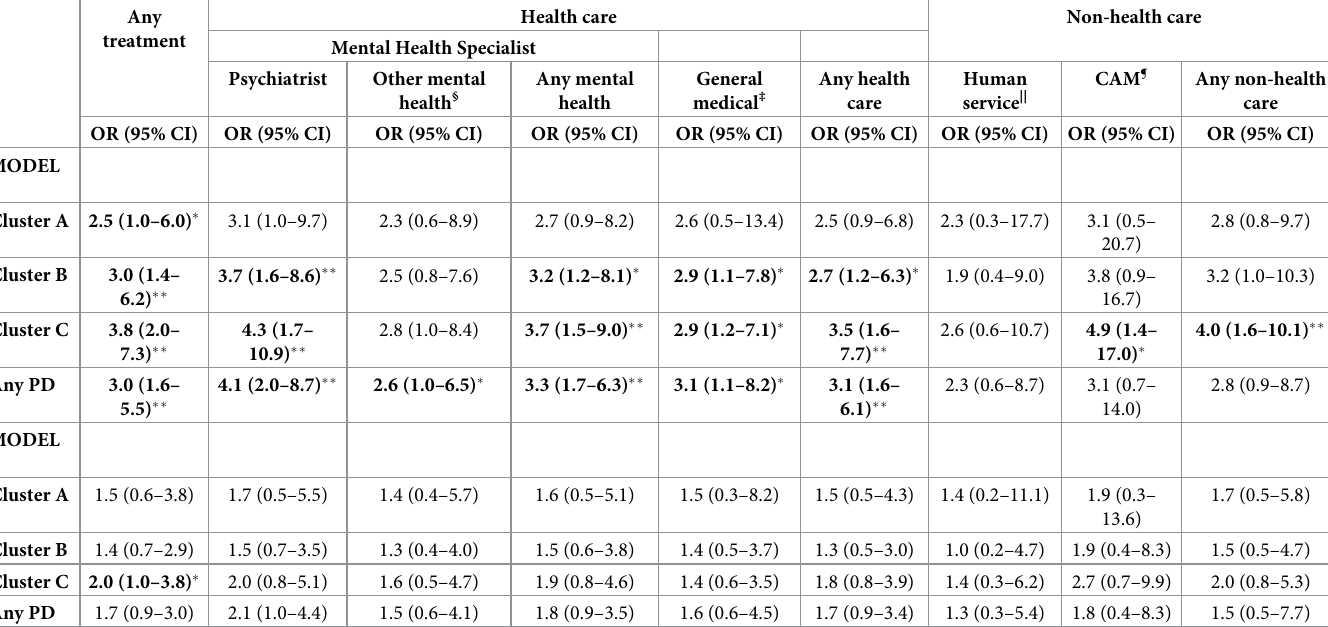
Table 8. Association between personality disorders and 12-month treatment in the Sao Paulo Metropolitan